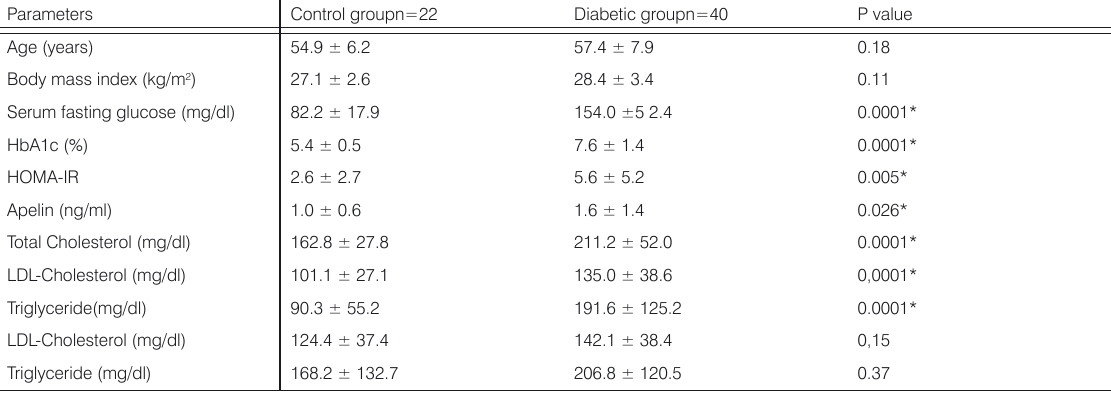
Table 1. Comparison of parameters in diabetic patients and the non-diabetic control